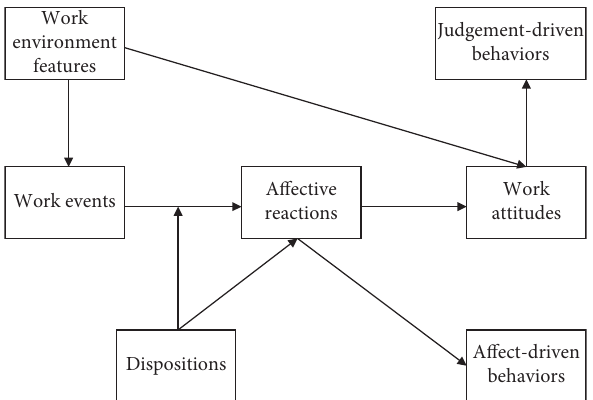
Figure 1: Schematic diagram of macroscopic structure of Affective Events